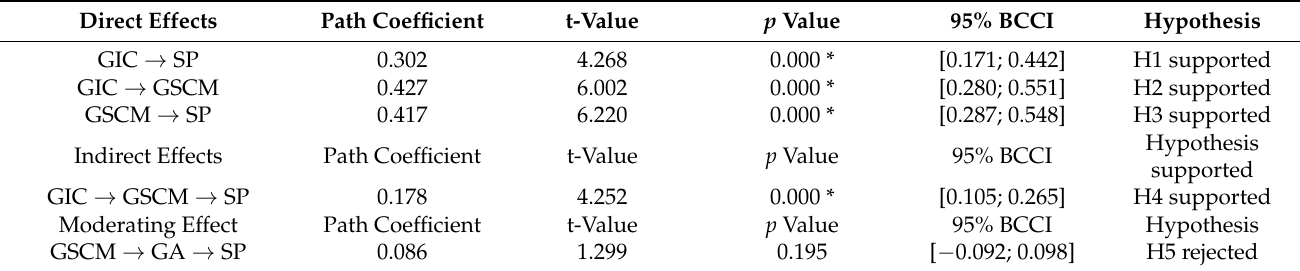
Table 5. Results of the structural model for the mediation